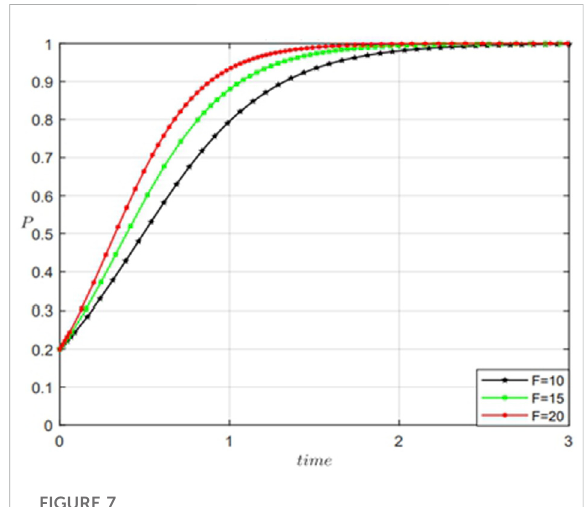
FIGURE 7 The effect of basic punishment F on the evolution of ECSNs.